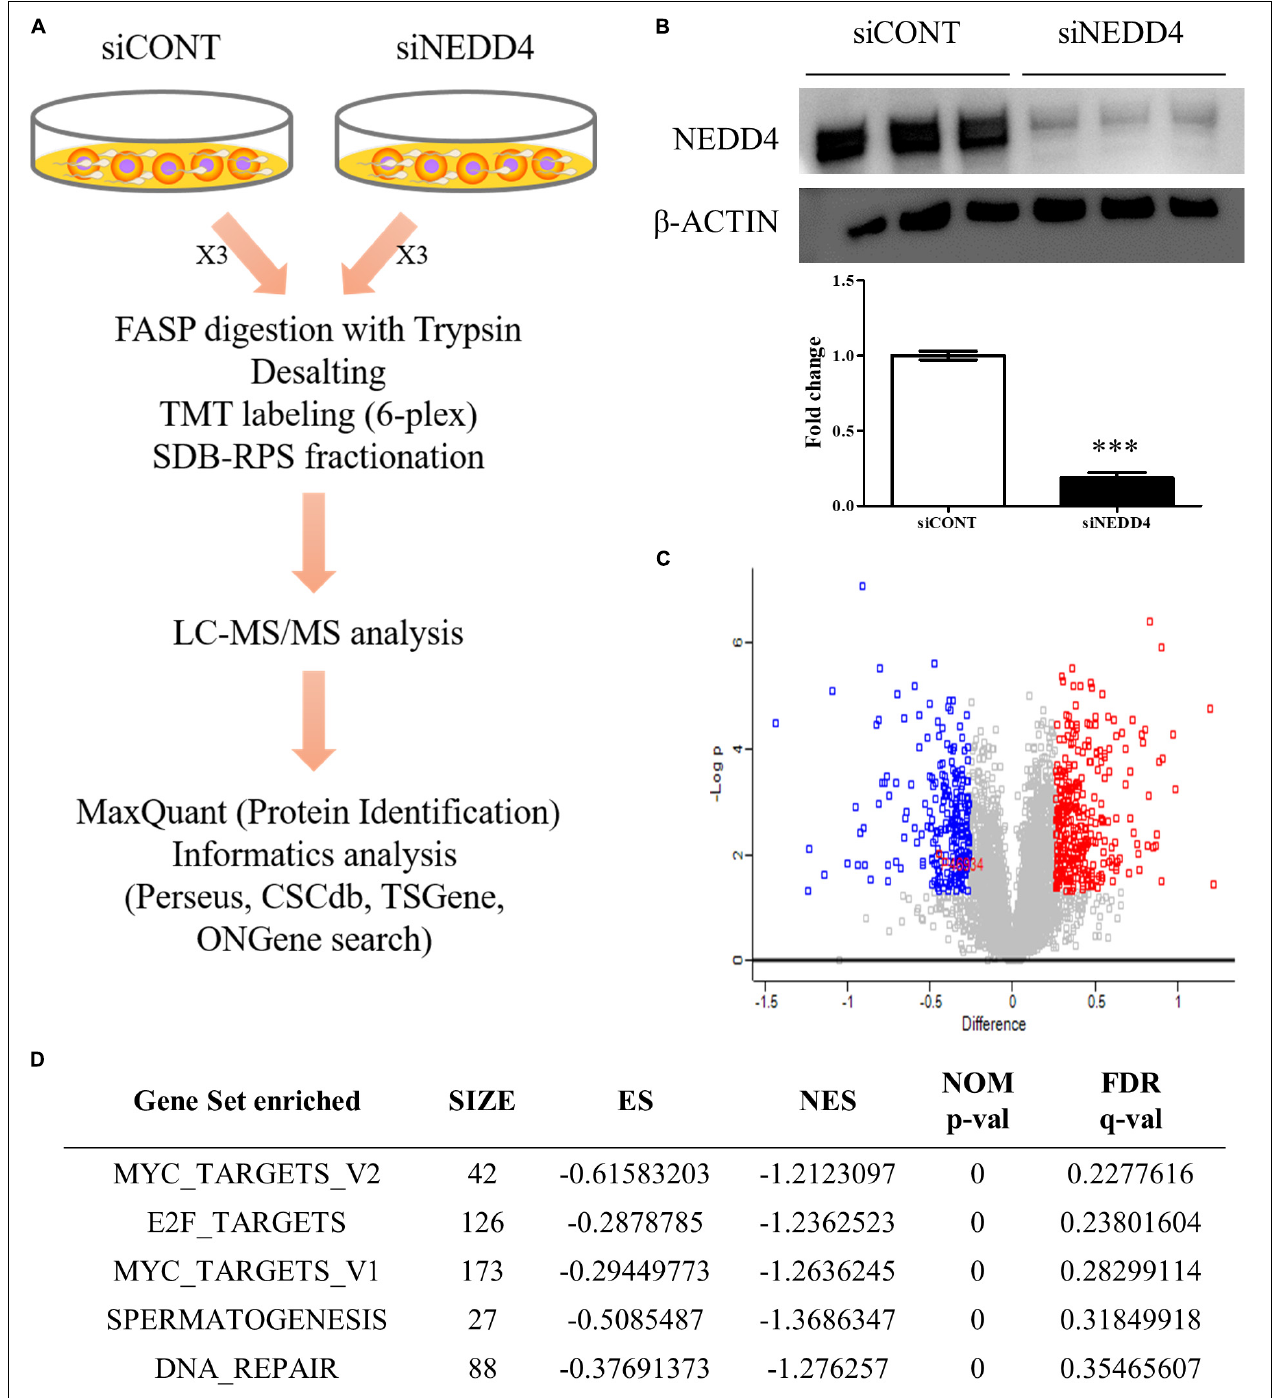
FIGURE 3 | Identification of differentially expressed proteins (DEPs) by liquid chromatography–tandem mass spectrometry (LC–MS/MS) analysis in NEDD4-deleted MDA-MB-231. (A) Schematic diagram showing the overall workflow for proteomics analysis in siCONT- and siNEDD4-treated MDA-MB-231. The peptides obtained by trypsin digestion were labeled by tandem mass tag six-plex reagents. Then, identification and functional analysis of DEPs were performed by LC–MS/MS and bioinformatics tools. (B) The efficiency of NEDD4 knockdown by transfection of siNEDD4 into MDA-MB-231 was confirmed by western blot with an anti-NEDD4 antibody. β -actin was used as a loading control. (C) The volcano plot obtained from “Perseus” shows differentially expressed proteins in siNEDD4-transfected MDA-MB-231 compared to siCONT-transfected ones. Proteins in red or blue were considered as significantly up- or downregulated by using Perseus software. (D) Gene set enrichment analysis showing the gene sets enriched in downregulated proteins by NEDD4 knockdown (*** P < 0.001).